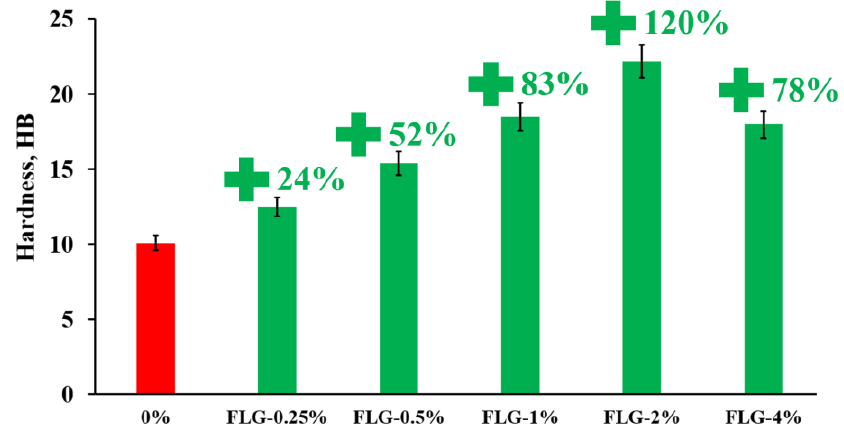
Figure 6. Brinell hardness of samples depends on the concentration of FLG.